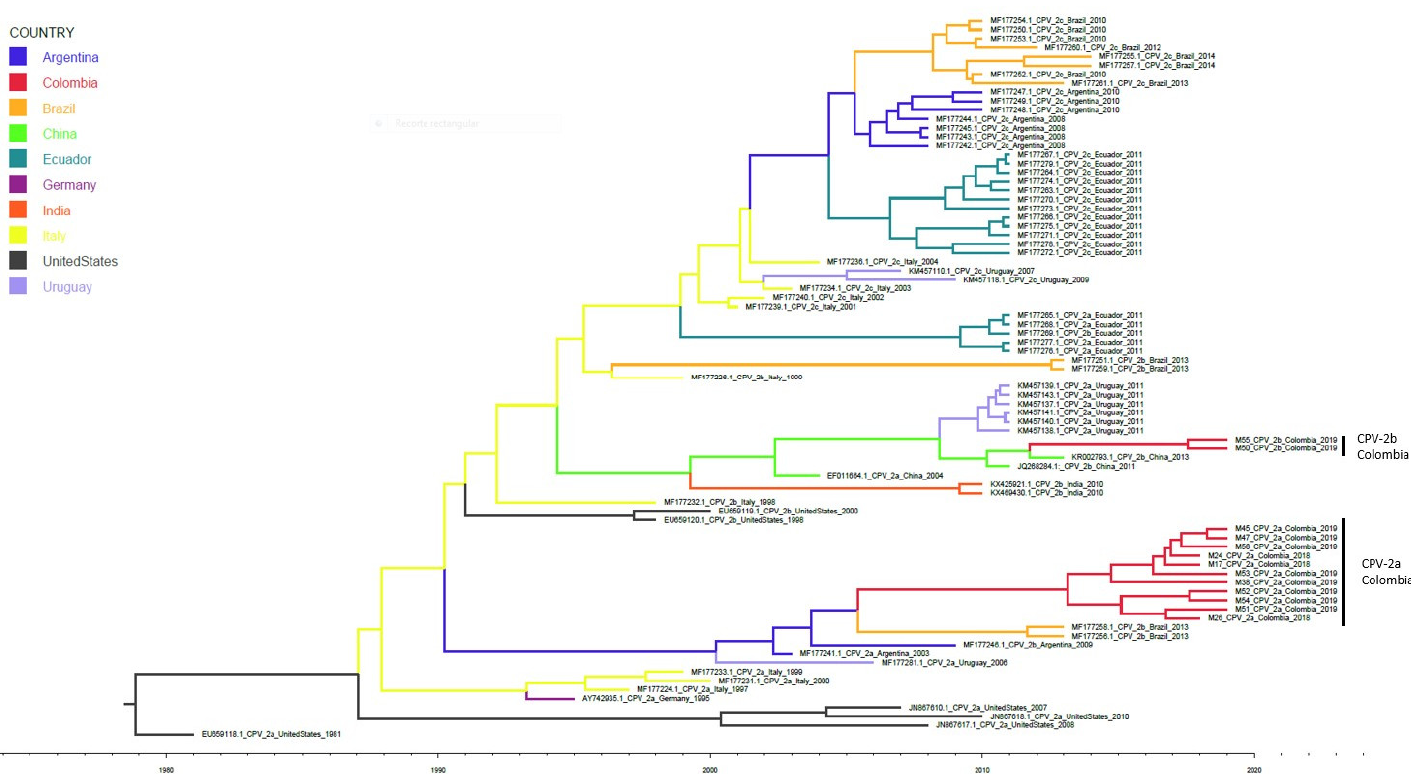
Figure 3. Phylogenetic evolutionary tree of Colombian CPV-2 variants. The tree was generated using CPV-2a, CPV-2b and CPV-2c variants from different countries. The sequences are identified with the accession number, country, and date of collection. The timeline shows the moment of evolutionary divergence of the sequences of each country. The common ancestor for both the Colombian CPV-2a and CPV-2b variants, in red, are sequences of Italian origin, represented in yellow. The Italian variants originated a clade with South American variants in 1990. In 2006, there is a divergence in the Argentine variants that originated the Brazilian variants and the Colombian CPV-2a variant. In 1994, a divergent branch appears that originated the Asian variants. In this clade, there are Chinese and Indian variants. Additionally, Uruguayan sequences related to the Chinese variants are found. In 2012, there is a divergence from the Chinese origin variants that originated the Colombian CPV-2b variant.